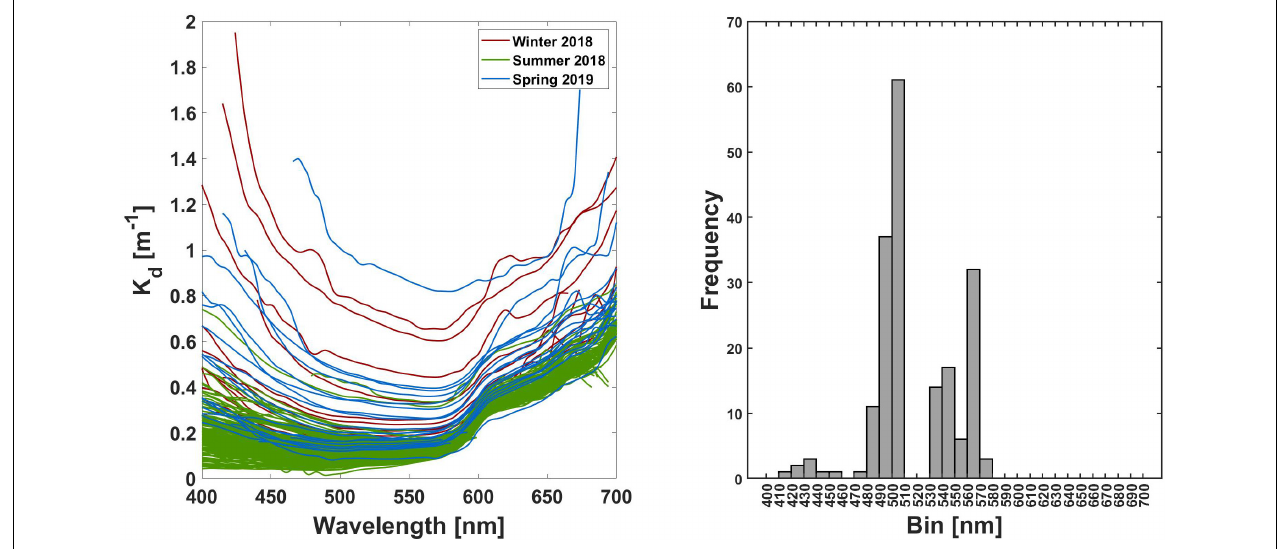
FIGURE 3 | Overview of K d ( λ ). Spectra obtained at the sampling sites (left) . Histogram of K d ( λ ) minimum wavelength distribution (right)